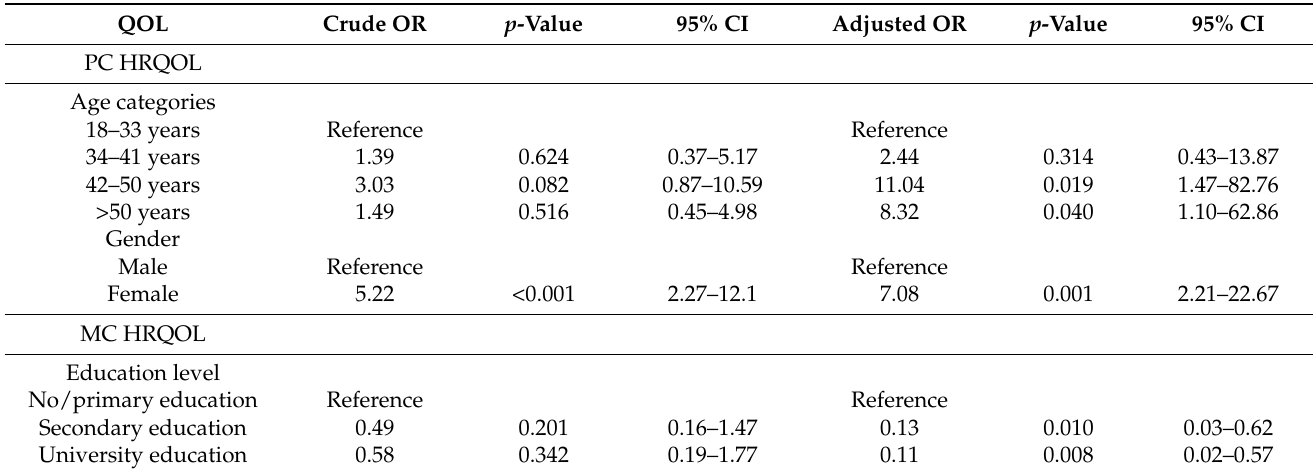
Table 6. Multivariable logistic regression analysis of poor PC and MC of QOL among participants with diabetes attending PHCC in